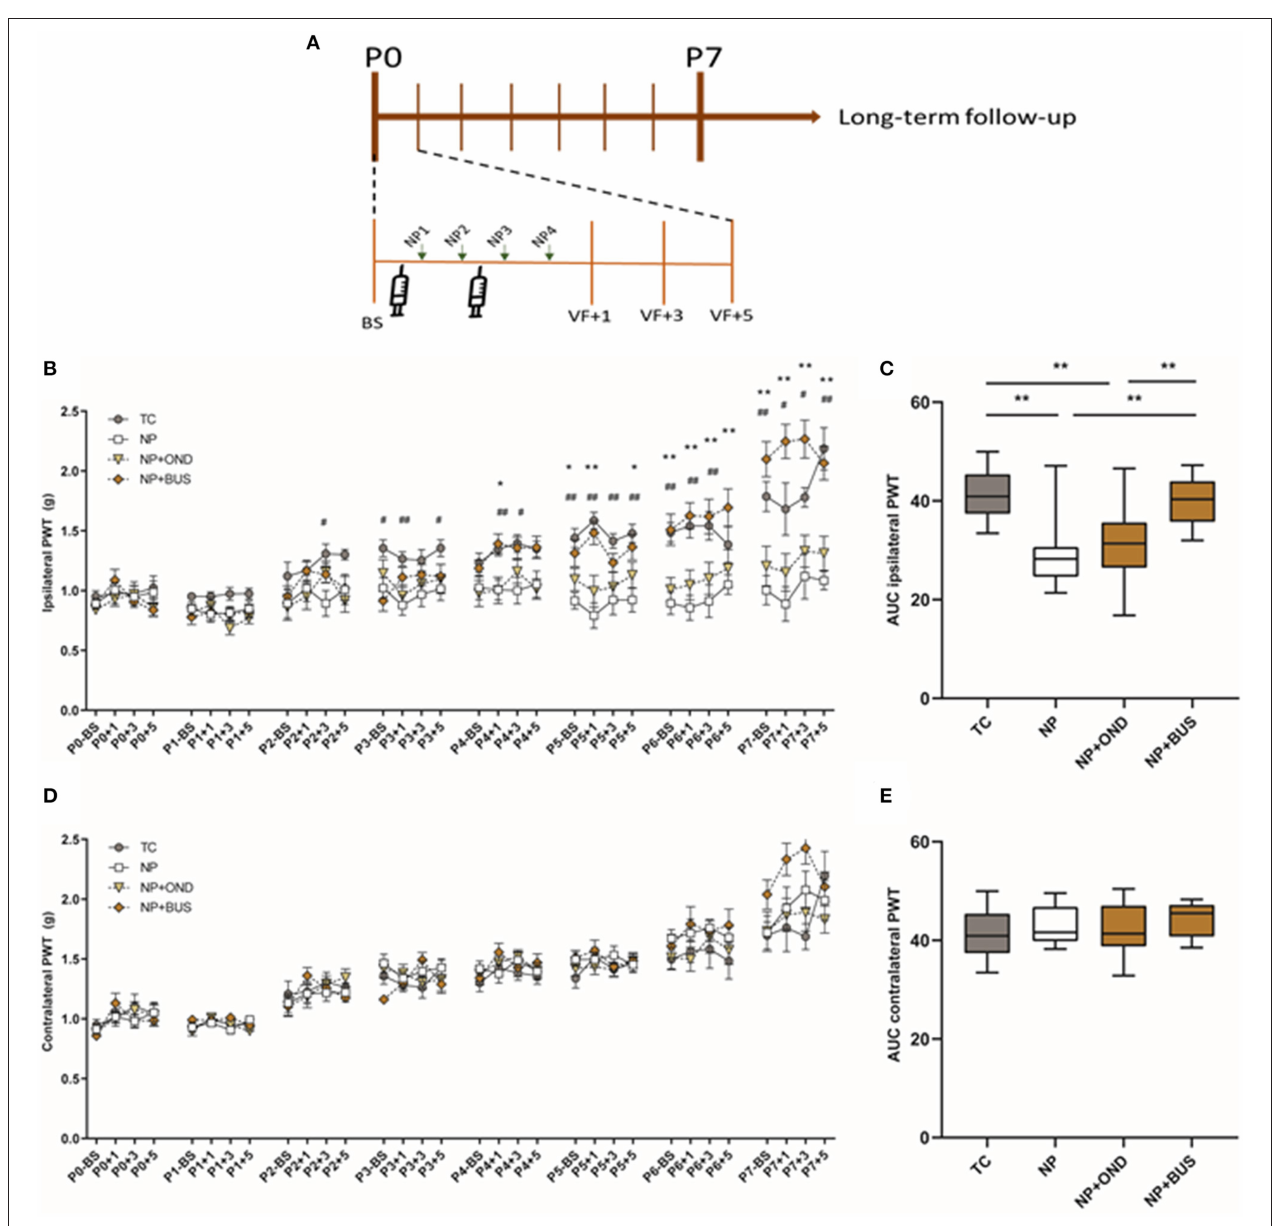
FIGURE 3 | (A) Graphical representation of timeline of experiment. Mechanical sensitivity to von Frey filaments during first neonatal week. (B) Repetitive needle pricking (NP; n = 12) results in a decreased paw-withdrawal threshold (PWT) in the ipsilateral paw as compared to repetitive tactile stimulation (TC; n = 12) from postnatal day (P) 2 onwards, indicating the development of acute mechanical hypersensitivity in NP pups. Neonatal 5-HT1aR agonism (NP + BUS; n = 12), but not 5-HT3R antagonism (NP + OND; n = 14), is able to reverse the acute mechanical hypersensitivity after repetitive needle pricking [interaction effect: F (93, 1426) = 4.798; p < 0.001]. (C) The area under the curve (AUC) over the entire neonatal period is significantly different between neonatal conditions for the ipsilateral paw-withdrawal thresholds (PWT) [F (3, 46) = 10.79; p < 0.01]. NP as well as NP + OND animals show a decreased AUC as compared to TC animals, whereas NP + BUS reverses the decreased AUC back to TC control values. (D) Mechanical sensitivity of the contralateral paw increases over time all groups, but was not affected by neonatal condition [F (3, 46) = 0.9085; p = 0.444]. (E) The area under the curve analysis (AUC) over the entire neonatal period does not show significant differences in contralateral PWTs between conditions [F (3, 46) = 0.9818; p = 0.4096]. BS, baseline measurement; NP, needle pricking animals; NP+BUS, needle prick animals receiving buspirone; NP+OND, needle prick animals receiving ondansetron; PWT, paw withdrawal threshold; P (0–7), postnatal day 0–7; + 1, + 3, + 5, measurement 1, 3, and 5 hours after needle prick or tactile stimulation; TC, tactile controls. Data is presented as mean ± SEM, NP vs. NP + BUS. * P < 0.05, ** P < 0.01, NP vs. TC, # P < 0.05, ## P < 0.01.